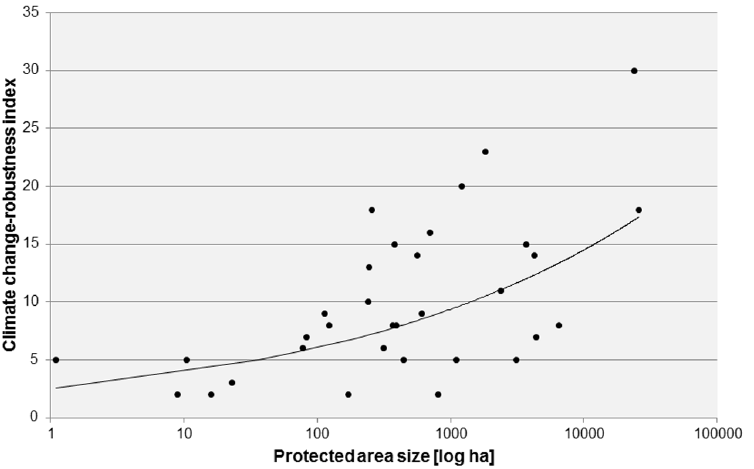
Fig 4. Relationship between protected area size and climate change-robustness of Natura 2000 sites. R = 0.58, p-value =